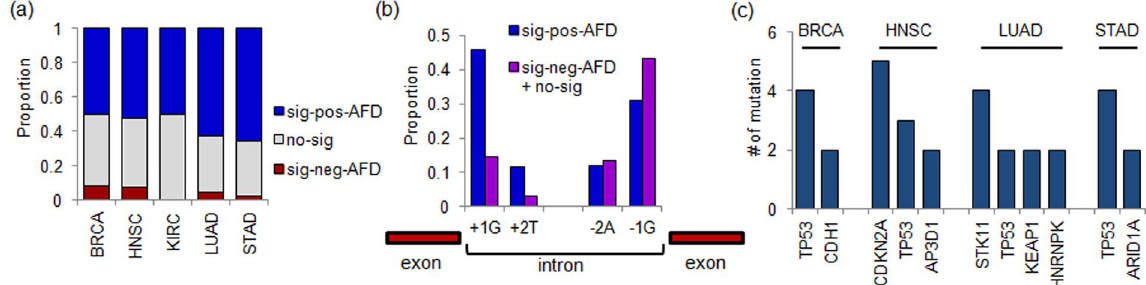
Figure 4. AI and splice site mutations. ( a ) Barplots show the relative proportion of sig-pos-AFD (blue), sig- neg-AFD (red), and the other mutations (gray) for splice site mutations across five tumor types. ( b ) The sig- pos-AFD ratio (blue) and the other ratio (purple) are shown at the canonical 5 ′ splice site (GT) and 3 ′ splice site (AG). ( c ) The frequency of the splice site mutations with the sig-pos-AFD are shown for genes with the ≥ 2 sig- pos-AFD events in the given tumor